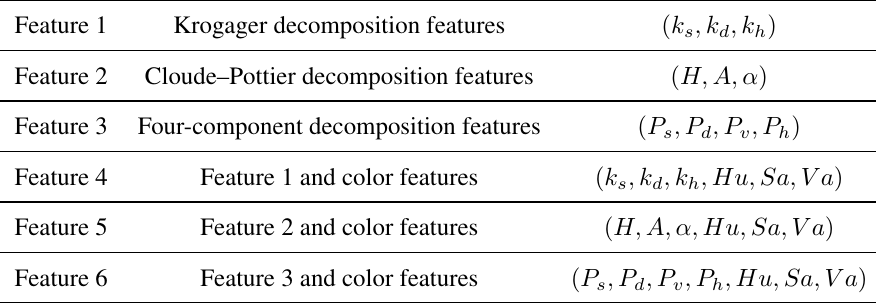
Table 1. The groups of